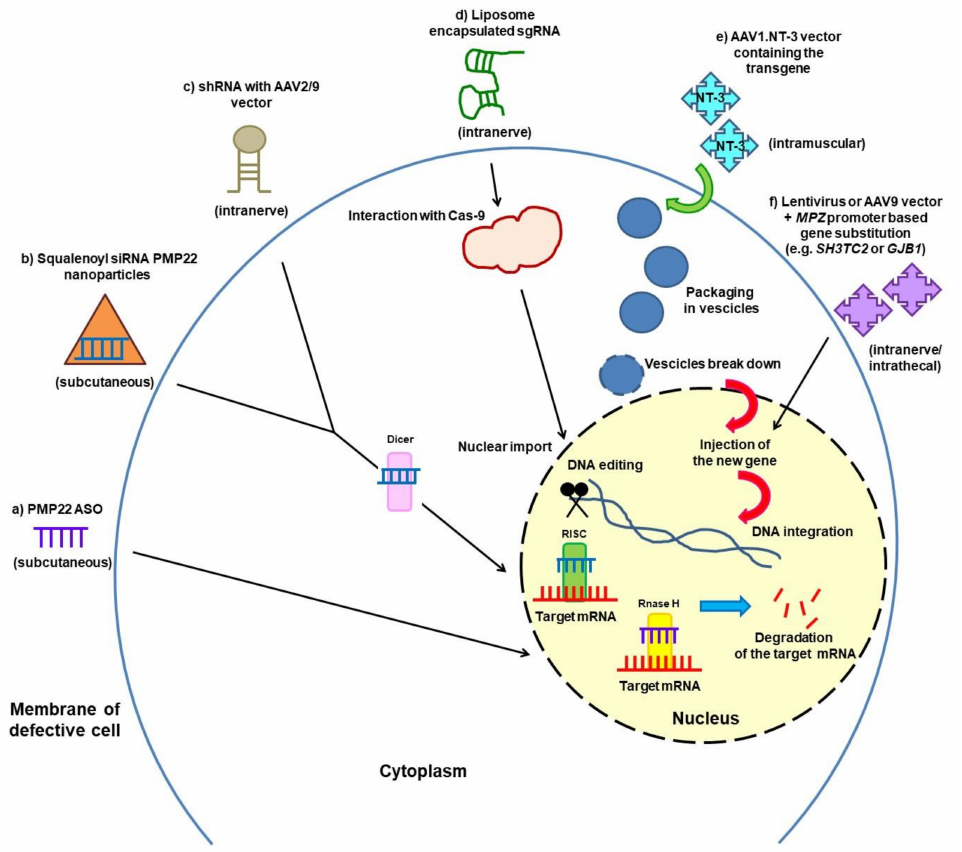
Figure 1. Partial silencing of PMP22 gene (a–d) and gene therapy against CMT1A and CMTX1 (e,f) in different rodent models. (a) ASOs decrease PMP22 mRNA in affected nerves in two CMT1A mouse models. (b) siRNAs conjugated to squalene nanoparticles normalise Pmp22 protein lev- els in two CMT1A mouse models. (c) AAV serotype 9 viral vectors expressing shRNA directed against PMP22 mRNA restore wild-type expression levels of PMP22 in CMT1A rats. (d) Liposome encapsulated sgRNAs delete the PMP22 TATA-box by CRISPR-Cas9 editing in a mouse model of CMT1A. (e) AAV1.NT-3 gene therapy in transgenic mouse models (TremblerJ and Cx32 knockout mice) and planned in three CMT1A patients. (f) Gene delivery using lentivirus or AAV9 vectors and a myelin-specific MPZ promoter to target murine Schwann cells (Sh3tc2 − / − and Cx32 knockout mice). For each approach, the route of administration is also indicated in